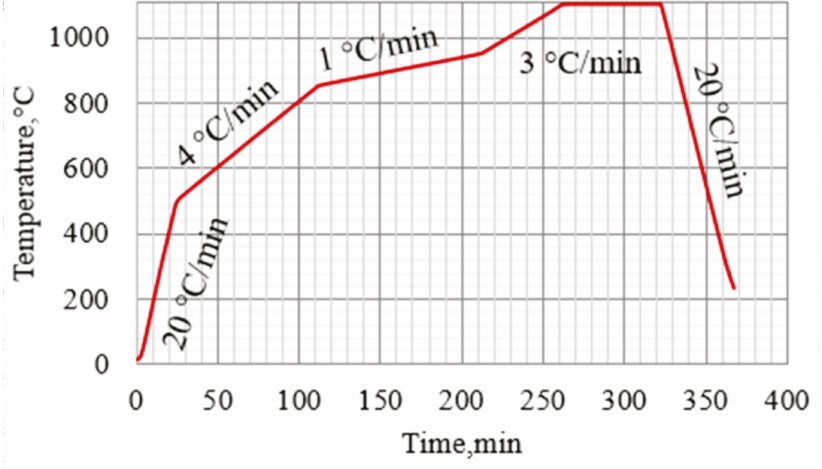
Figure 1. Simulated BF thermal profile used in TGA and for tube furnace tests.